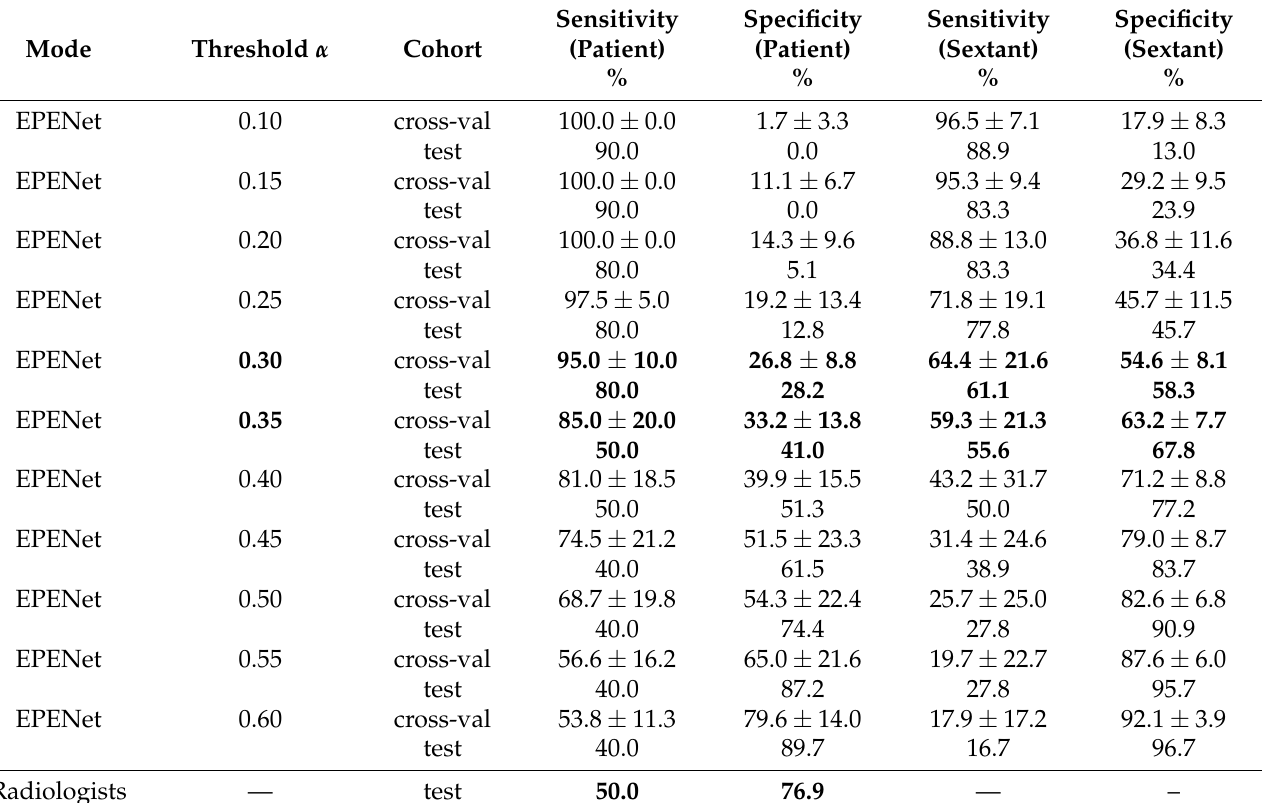
Table 4. Sensitivity and specificity results in the cross-validation and test sets for the EPENet model operating at various binary thresholds α . We recommend 0.30 ≤ α ≤ 0.35 as the optimal operating range for this model. Results within the recommended operating range are shown in